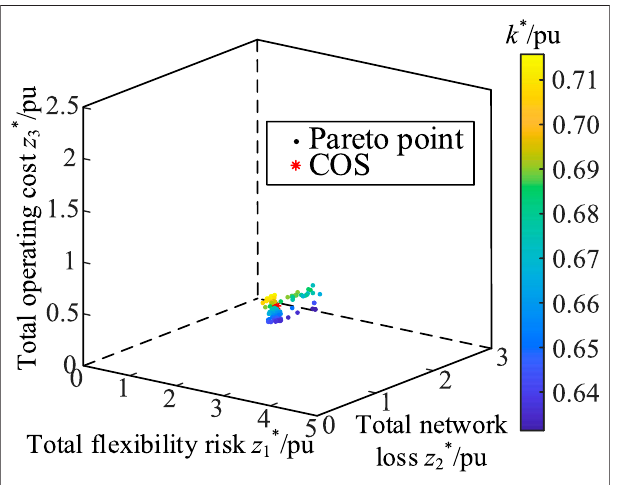
FIGURE 5 | Power output schedule of the units.